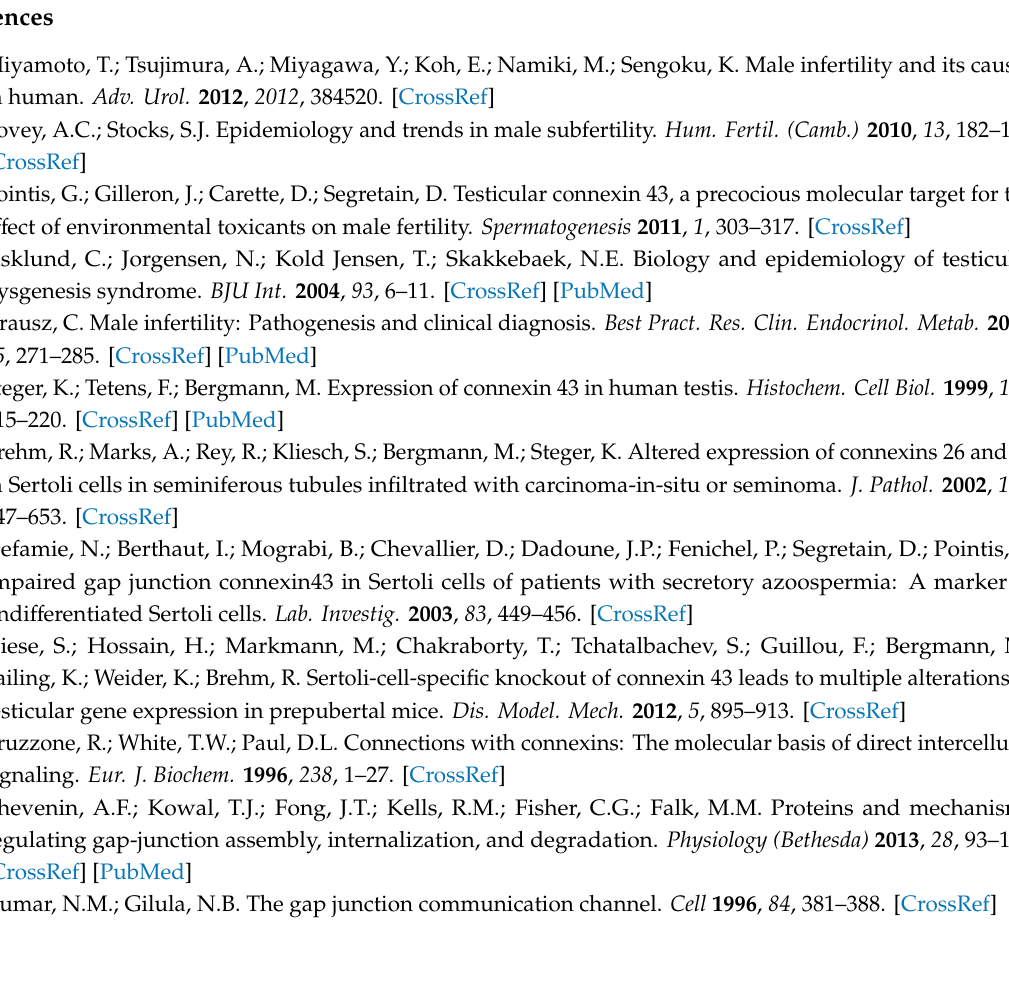
Table S15: NGS_GSEA_GO_WholeData_normalized, Table S16: NGS_GSEA_GO_day8_normalized, Table S17: pathways of all significantly altered genes, Table S20: PANTHER pathways of the candidate genes, Table S21: Di ff erential gene expression of connexins in SCCx43KO